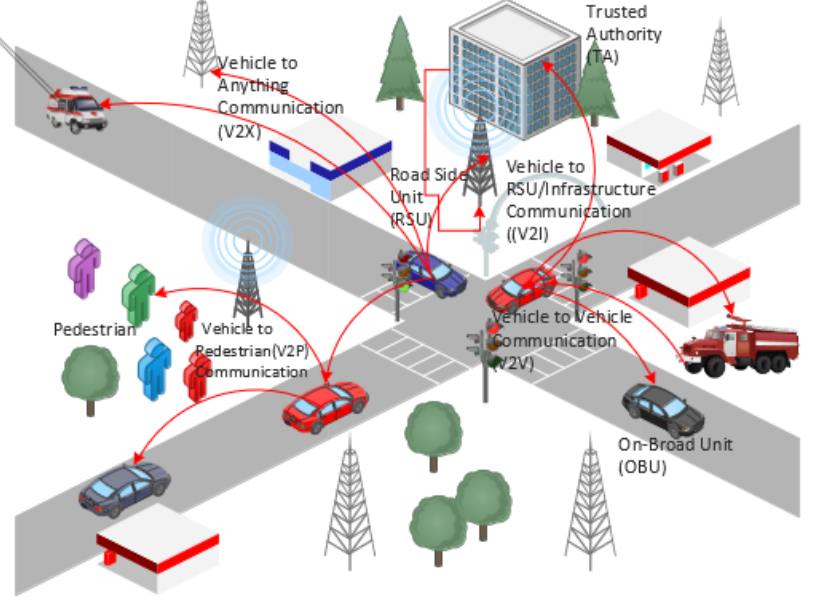
Figure 1. VANET architecture